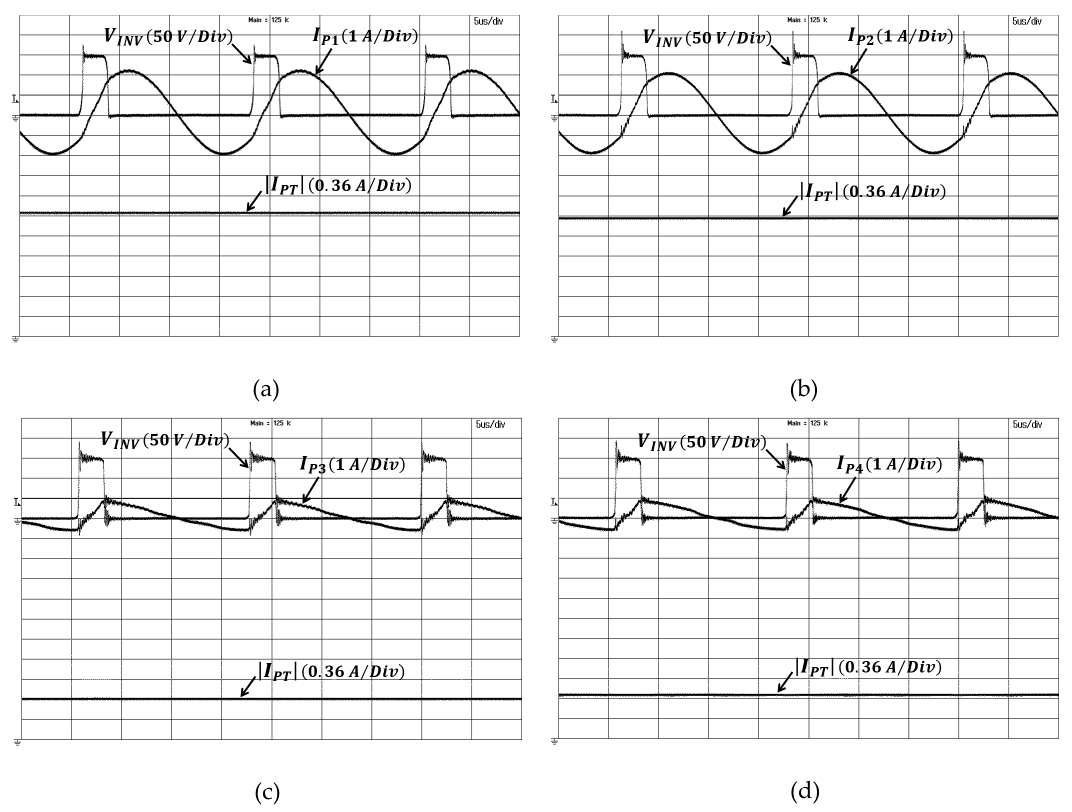
Figure 19. Experimental waveforms of the system under detection mode operation: ( a ) Transmitter coil number 1 is excited; ( b ) Transmitter coil number 2 is excited; ( c ) Transmitter coil number 3 is excited; ( d ) Transmitter coil number 4 is excited.